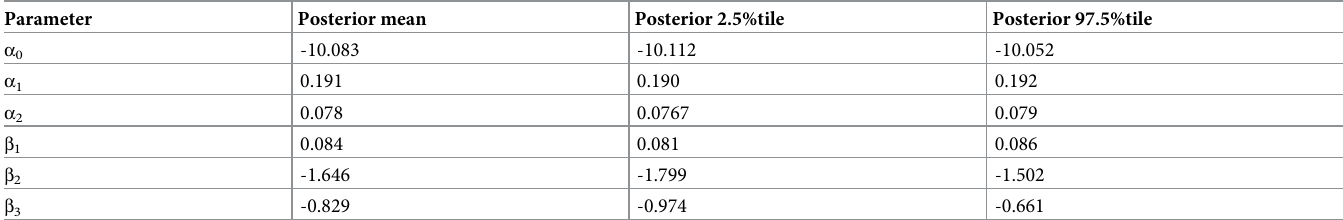
Table 2. South Carolina model 5A parameter estimates (with regression estimates β � ).